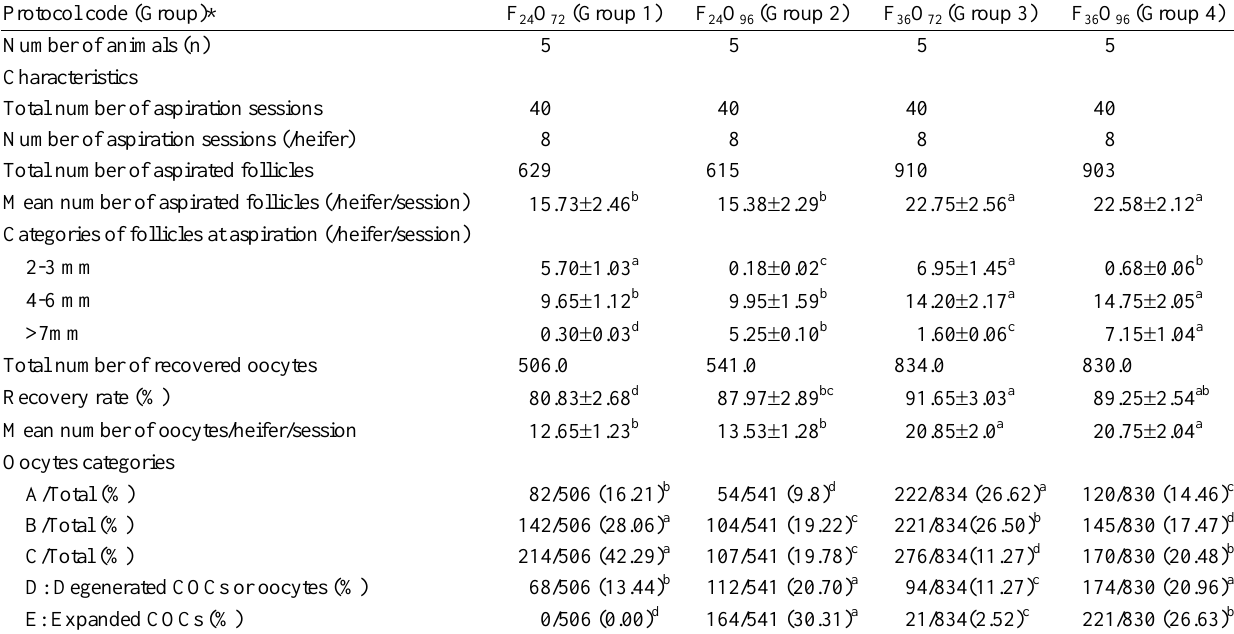
Table 2. Total number and mean values (Mean  SEM) of recovered COCs and classification of COCs collected undergoing repeated superstimulation of ovarian follicular growth and OPU in Thai native heifers